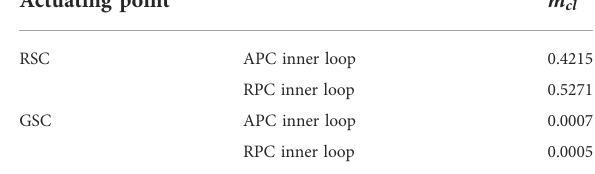
TABLE 8 The m cl of oscillation